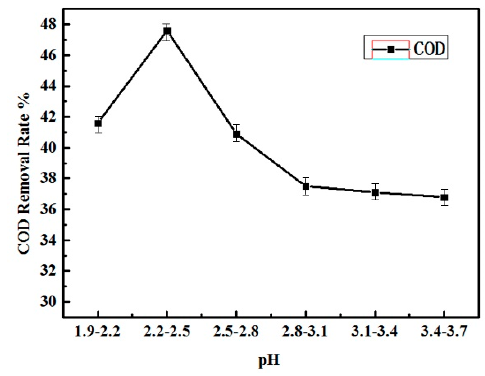
Figure 3. COD removal with pH value in Fenton Unit (Fe 2+ /H 2 O 2 molar ratio = 1:3) (error = ±5%).